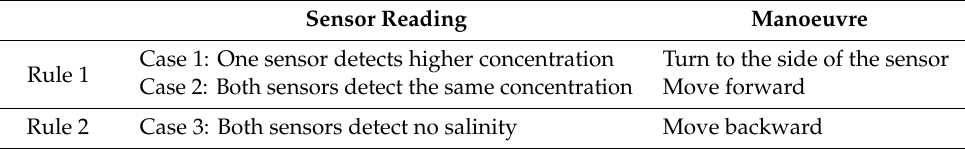
Table 12. Rules in the chemotaxis algorithm proposed by Grasso et al.